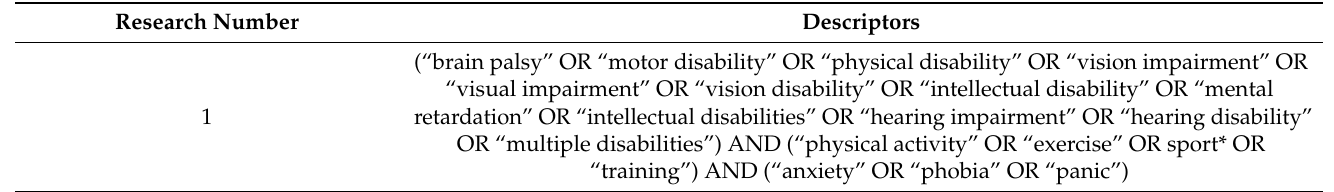
Table 1. Research